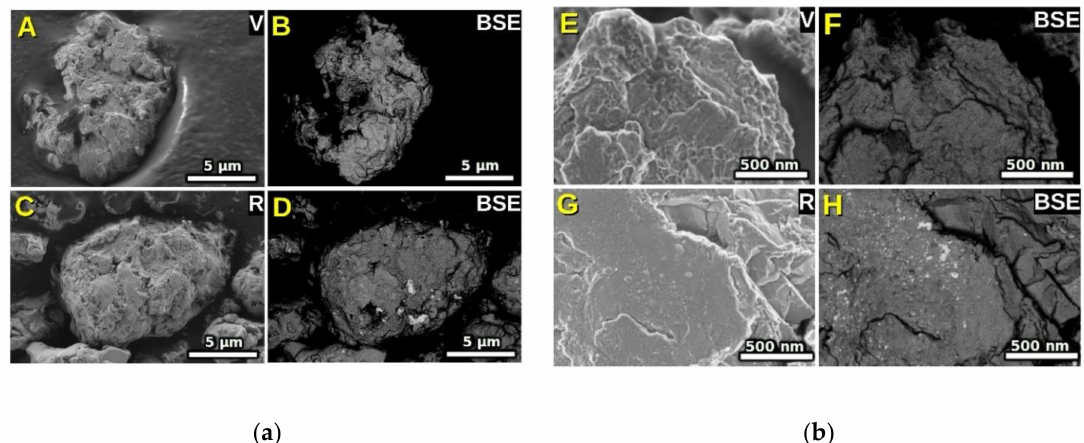
Figure 1. ( a ) SEM images at a scale of 5 µ m of SmCo 5 + 10 wt% Fe nanocomposite powders made using virgin (V) SmCo 5 imaged by secondary electrons (Panel A) or backscattered electrons (Panel B) and recycled (R) SmCo 5 imaged by secondary electrons (Panel C) and backscattered electrons (Panel D). ( b ) higher magnification images at a scale of 500 nm; Panels E, F, G and H are higher magnification images of A, B, C and D respectively.